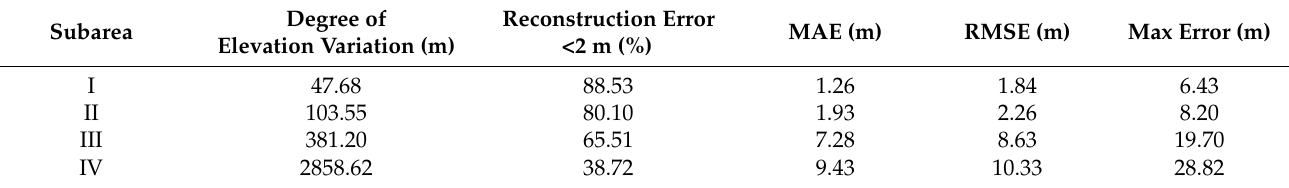
Table 3. Reconstruction error of